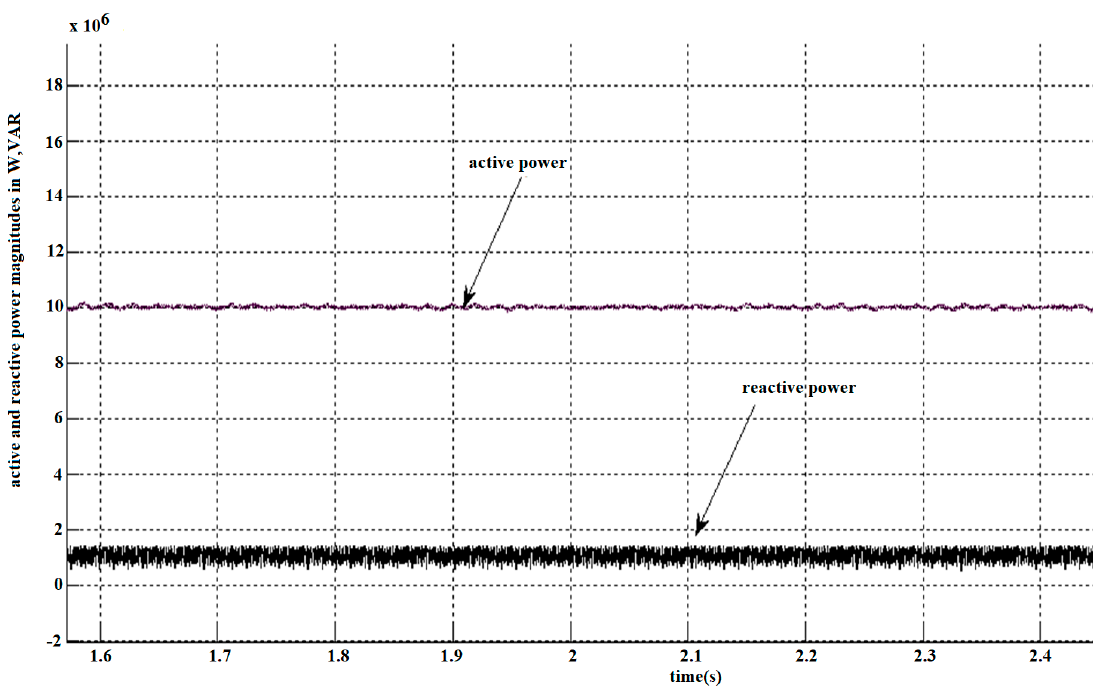
Figure 37. Active and reactive power behavior across the load.